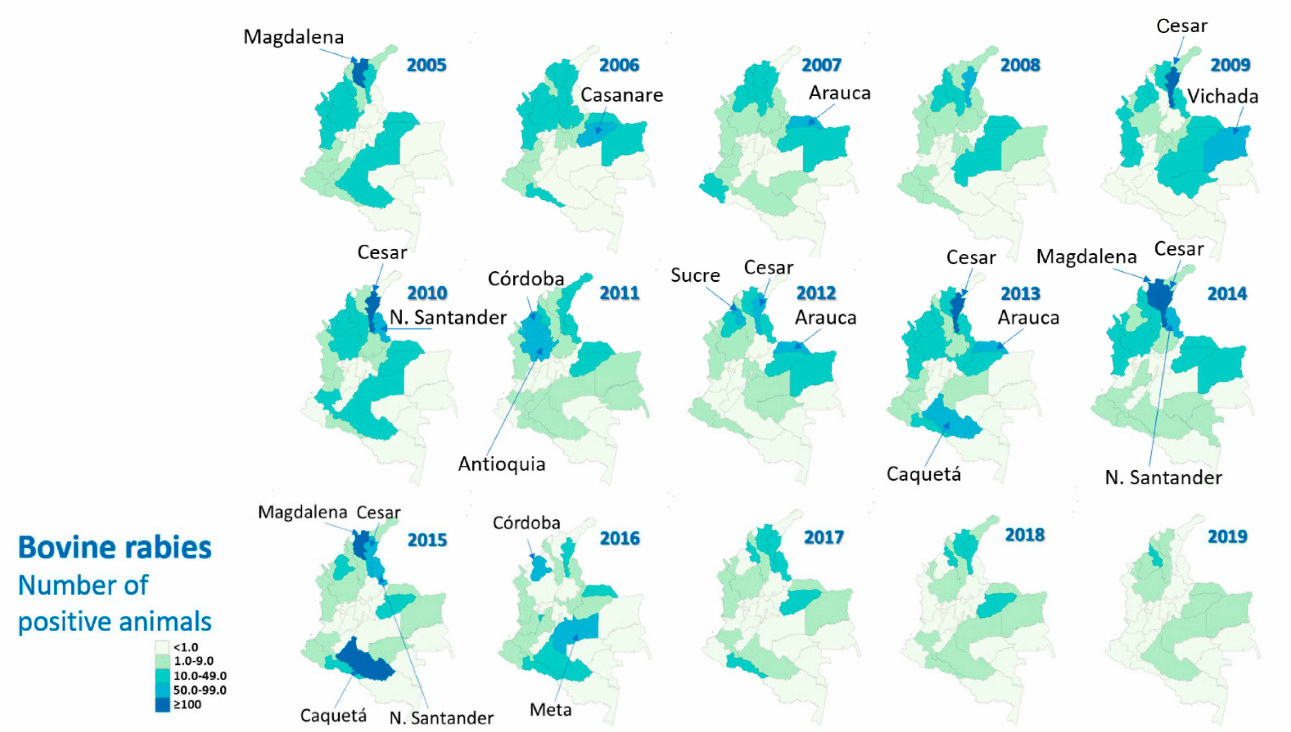
Figure 6. Geographical distribution of bovine rabies by department, Colombia, 2005–2019.